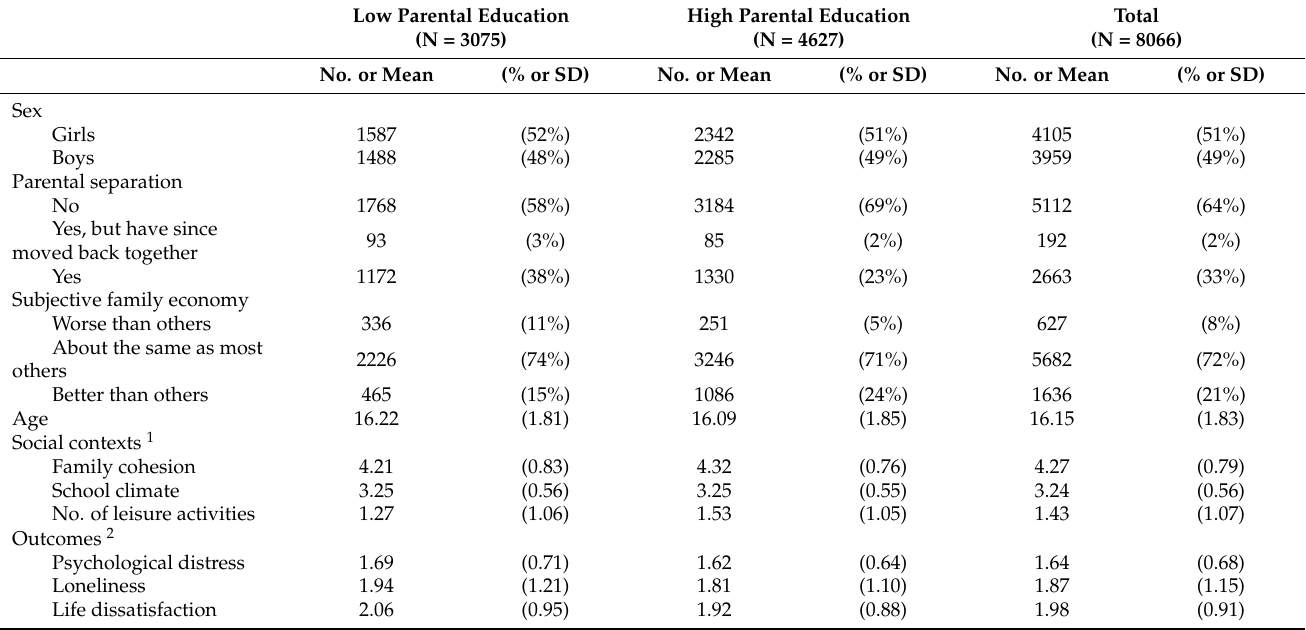
Table 1. Descriptive statistics of the Young-HUNT4 Survey